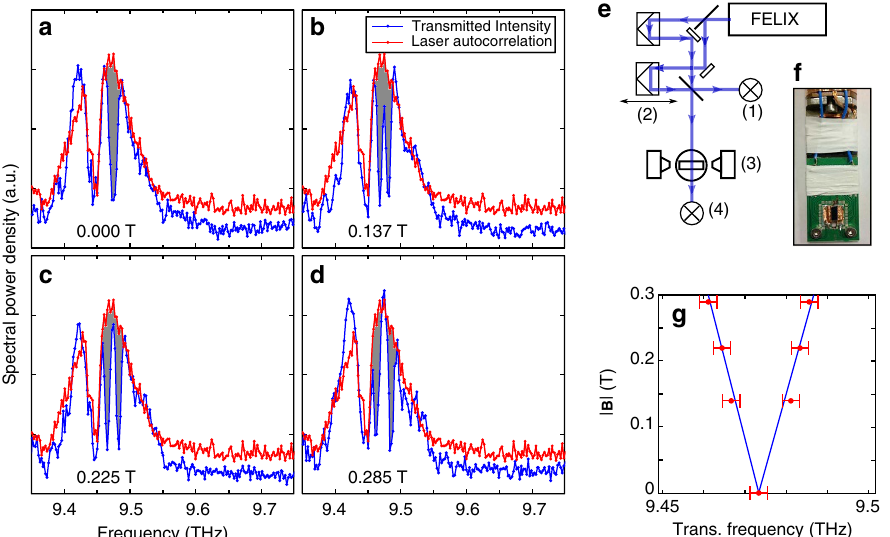
Figure 4 | Frequency domain quantum beats in transmission. ( a – d ) Transmission spectra of the sample under varying magnetic field amplitudes, noted in the figure. Each panel shows the FTof the time-domain Ramsey fringes in the transmitted light (single channel, that is, unratioed with any reference) for different applied magnetic fields (blue points). The linear autocorrelation of the laser, that is, the FT of the fringes taken simultaneously with a reference detector at the other exit port of the interferometer (red points) is clearly about 0.1THz wide, and there is evidence of absorption lines from residual water vapour in the beam path (for example, at 9.45THz). The absorption peaks due to the sample are highlighted with a grey fill. ( e ) Optical layout schematic of the experiment: (1) autocorrelation reference detector, (2) computer controlled delay stage, (3) sample cryostat between electromagnet poles, (4) primary transmission measurement. ( f ) Photograph of the sample mounted upon the cold-finger, supported strain-free by copper foil capacitor plates. There is an aperture behind the sample to allow transmission. ( g ) Measured sample transmission line-centres (red points) taken from the shaded features in the main panels (error bars indicate the datapoint spacing in the spectrum). The blue lines show the theory for the 1 s (A 1 ) to 2 p ± transitions from Fig.